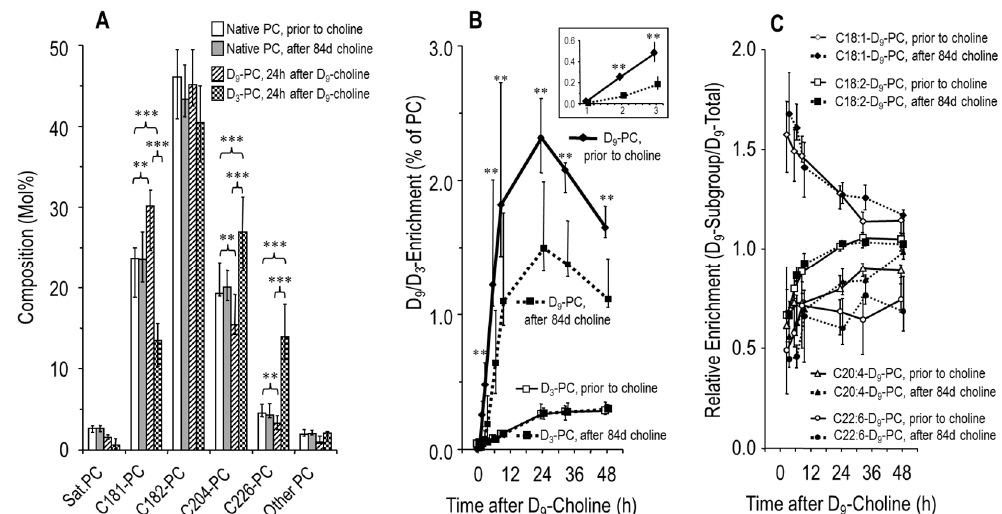
Figure 6. Molecular composition and kinetics of plasma phosphatidylcholine (PC) in response to choline supplementation. ( A ) PC molecular species grouped according to their content of different fatty acid residues in sn-position 2 (Sat. PC, C18:1-PC, C18:2-PC, C20:4-PC or C22:6-PC). White panels indicate the median PC composition prior to choline supplementation (visit [V] 2-4, whereas grey panels are values after 84 d choline supplementation (V6-8). Striped panels indicate the molecular composition of PC synthesized de novo (D 9 -PC), whereas dotted panels indicate synthesis via methylation of phosphatidylethanolamine (D 3 -PC) [13,27]. ( B ) D 9 - and D 3 -enrichment of PC prior to and after choline supplementation. ( C ) The relative synthesis rates and kinetics of plasma PC sub-groups are identical prior to (visit [V] 2–4) and after (V6–8) 84 d choline supplementation. Data are medians and interquartile ranges of N = 10. Abbreviations: ** p < 0.01; *** p < 0.001.